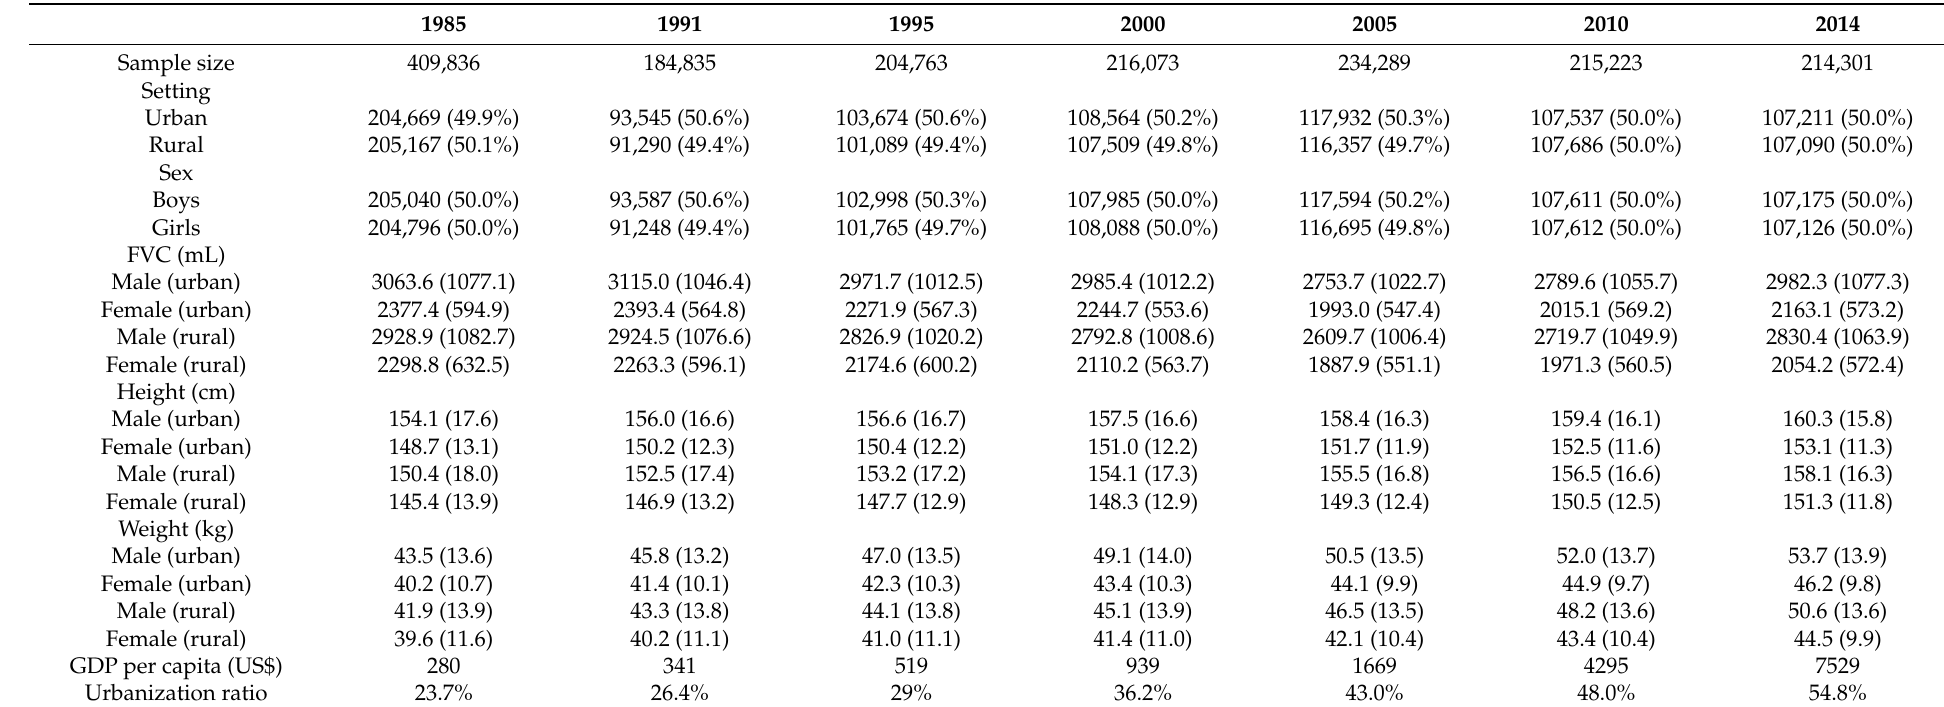
Table 1. Data for different survey years from the Chinese National Survey on Students’ Constitution and